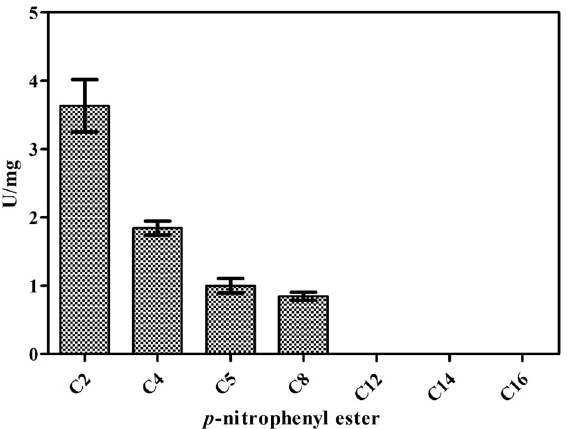
Figure 6. Affinity of XylR for esters of different carbons. Legend: (C2) p -nitrophenyl acetate, (C4) p -nitrophenyl butyrate, (C5) p -nitrofenyl valerate, (C8) p -nitrophenyl octanoate, (C12) p -nitrofenyl dodecanoate, (C14)